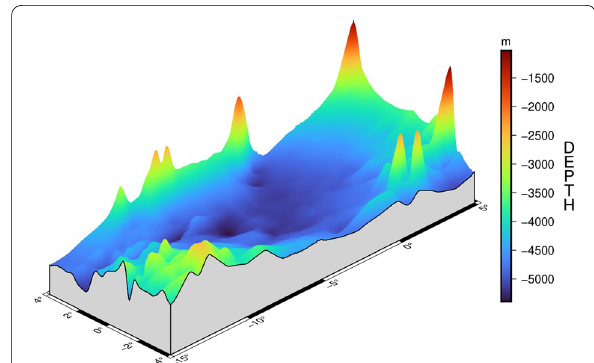
Fig. 12 Bathymetry of study area predicted by HY-2A-derived gravity anomaly